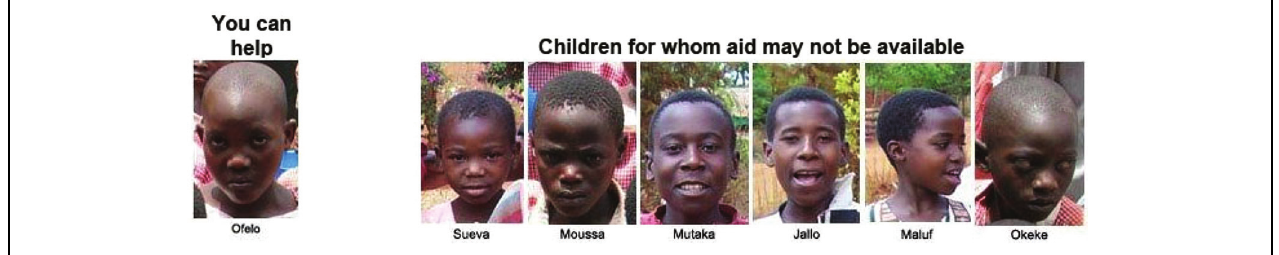
FIGURE 1 | Example of stimulus materials for one condition.